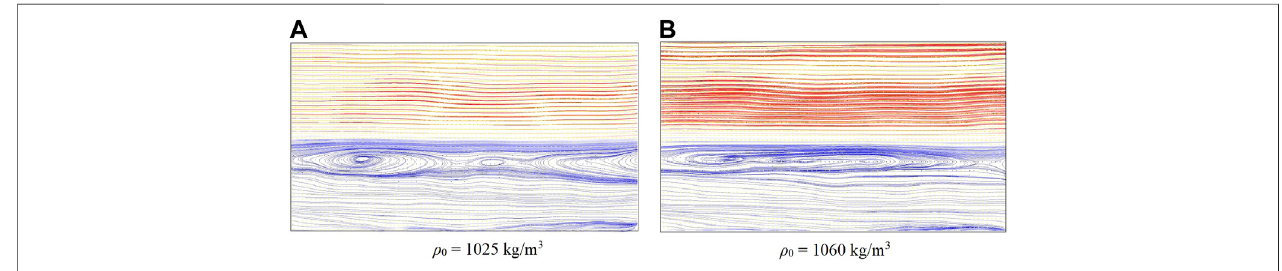
FIGURE 6 | PIV snapshots of the streamlines on the spanwise central plane at x = 12 z i from the test channel inlet for the cases of Q S = 20 L/h and U 2 = 0.08 m/s with, (A) ρ 0 = 1,025 kg/m 3 (case 9), and (B) ρ 0 = 1,060 kg/m 3 (case 12),